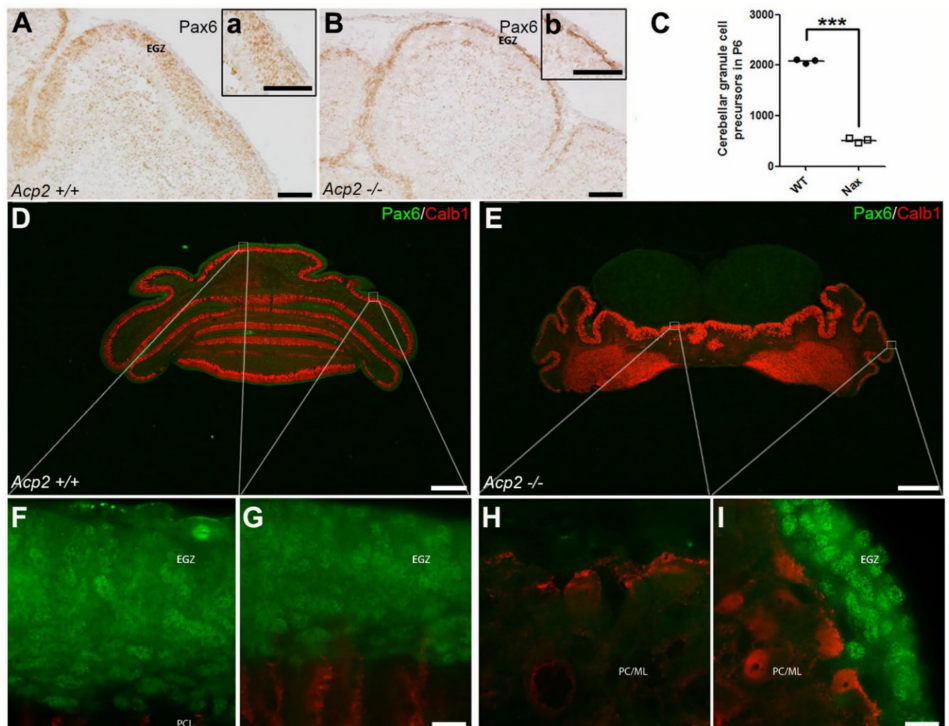
Figure 2. The number of cerebellar GC precursors is decreased in the nax mouse. ( A ) Sagittal section of P6 wt mouse cerebellum immunostained with PAX6 shows GC precursors in the external germinal zone (EGZ); higher magnification provided in ( a ). ( B ) Sagittal section of P6 nax mouse cerebellum immunostained with PAX6 reveals that the number of GC precursors is markedly lower than in the wt cerebellum; higher magnification provided in ( b ). ( C ) Cell counting of sagittal sections of P6 cerebellum shows a significant difference in the number of GC precursors during early postnatal age between wt and nax . The bars represent the average cell counts of cerebellar sections obtained at P6 from wt and nax littermates (wt; n = 3 and nax ; n = 3) and show that the number of GC precursors in nax is only about 20% of that scored in wt. The data in the graph are presented as the mean ± SEM, and statistical analysis was performed using unpaired t -test (*** p < 0.001. ( D – I ) Frontal sections of wt ( D ) and nax ( E ) cerebellum at P8 immunostained with PAX6 (green) and CALB (red). ( D ) In the wt cerebellum, a thick external germinal zone (EGZ) could clearly be observed medially ( F ) and laterally ( G ). ( E ) In the nax mutant, the number of proliferating GCs was strongly reduced in the EGZ as compared to the wt; GCs appeared completely absent medially ( H ) , and only a thin EGZ could be identified laterally ( I ). Abbreviations: EGZ, external germinal zone; ML, molecular layer; PCL, Purkinje cell layer. Scale bars: 500 µ m in ( A , B ), 100 µ m in ( a , b ), 1000 µ m in ( D , E ), 20 µ m in ( G ) applies to ( F – G ), and 20 µ m in ( I ) applies to ( H , I